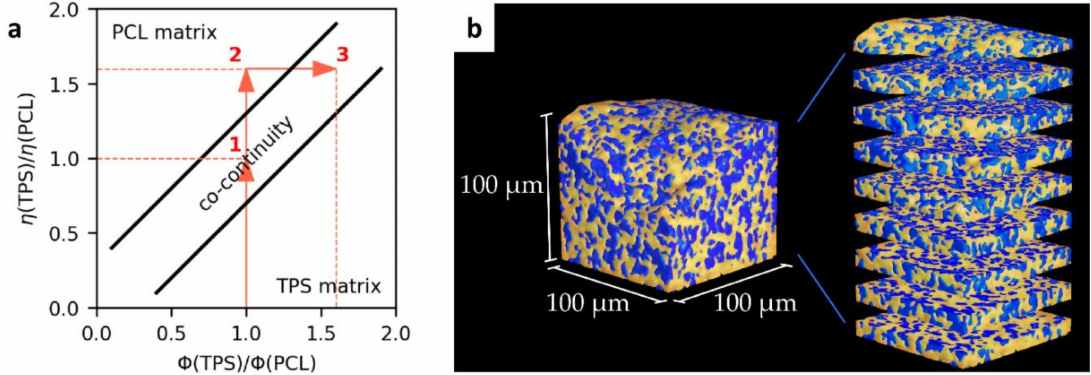
Figure 5. Phase co-continuity in TPS/PCL blends: ( a ) a theoretical prediction of the TPS/PCL composition exhibiting co-continuous morphology and ( b ) an experimental proof of co-continuity in the TPS/PCL (70/30) blend by means of sub µ -CT measurement. The theoretical prediction ( a ) suggested that co-continuous morphology should appear at higher concentrations of TPS (as explained in Section 3.1.4). The experimental verification of the co-continuity of the TPS/PCL (70/30) blend ( b ) is displayed in the form of a 3D reconstruction of 100 × 100 × 100 µ m 3 volume of the sample measured by sub µ -CT. The model illustrates co-continuity in both phases. The etched-off phase (TPS; shown in blue) forms interconnected pores. The connections among the pores can be observed in the thin slices on the